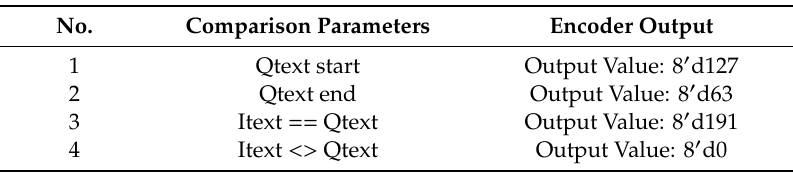
Table 1. Key encoder.